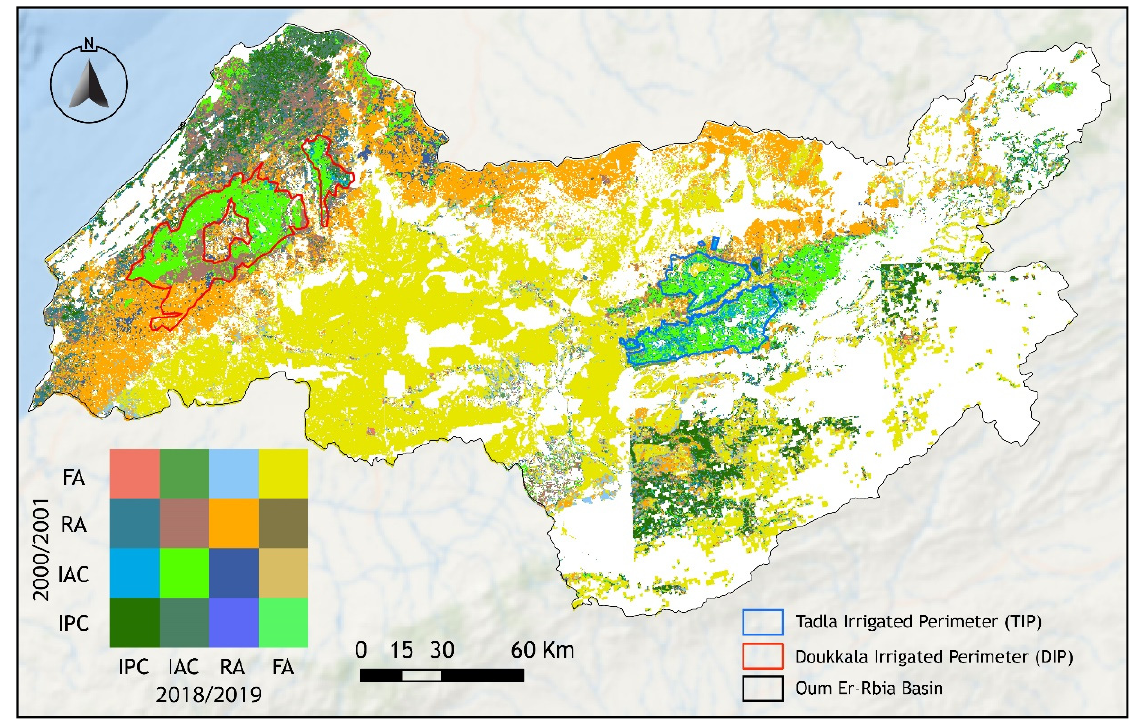
Figure 7. Change map of farming systems (FSs) over the OER basin from 2000 to 2019. The diagonal of the square represents the unchanged classes of farming systems.